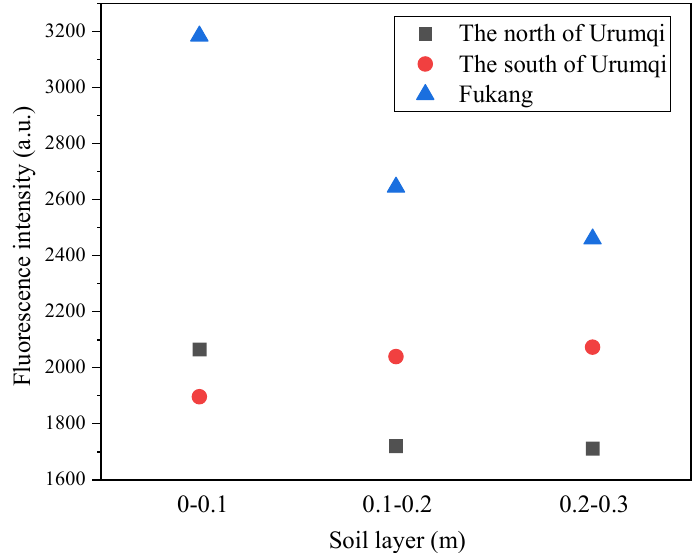
Figure 3. Average fluorescence intensities of different soil depth on different districts. The fluorescence index (FI) often indicates the sources of DOM. Generally, there are two main sources of plant and microbial metabolites with FI values of 1.4 and 1.9, re- spectively[40,41].When FI < 1.4, DOM is mainly from plant sources. When FI is between 1.4 and 1.9, DOM is from both plant and microbial metabolites. While FI > 1.9, DOM is dominated by microbial metabolite sources (such as tyrosine and tryptophan)[44].In this